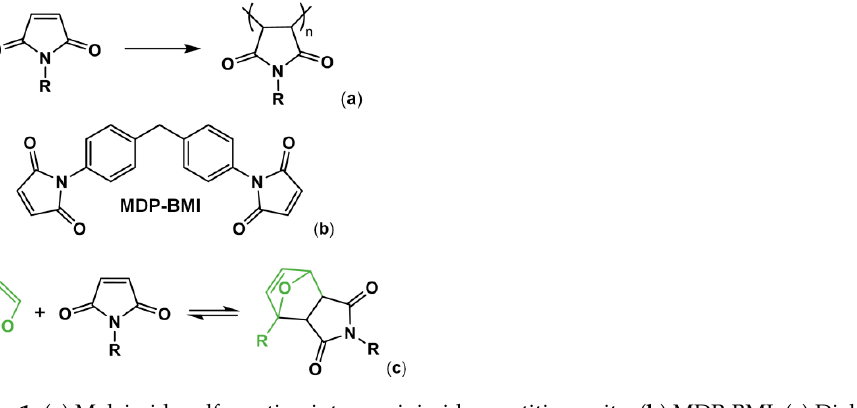
Figure 1. ( a ) Maleimide self-reaction into succinimide repetitive units. ( b ) MDP-BMI. ( c ) Diels-Alder (DA) thermo-reversible reaction between furan and maleimide.